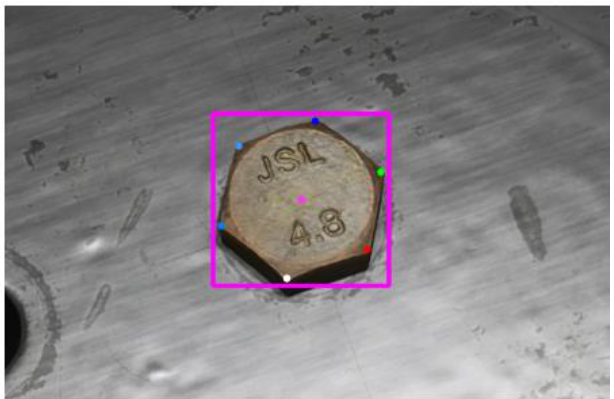
Figure 10. The result of key-point labeling and recognition box generation.